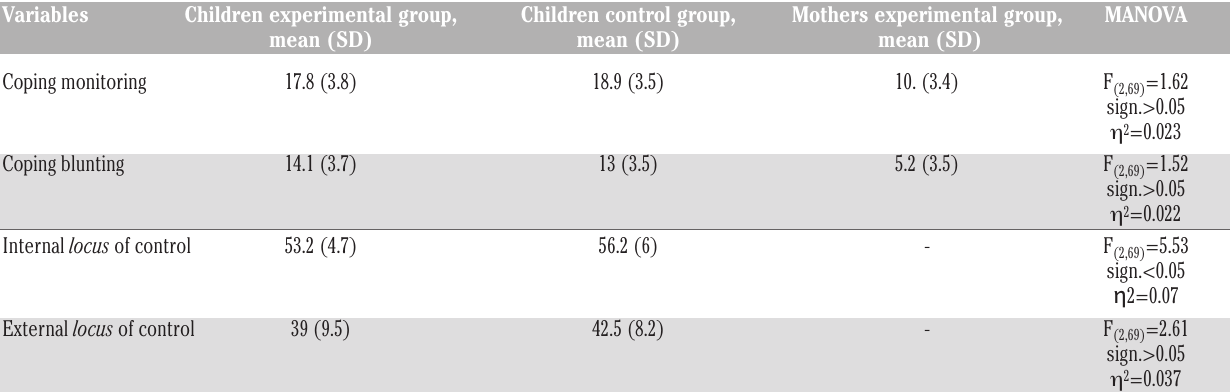
Table 2. Descriptive statistics and multivariate analysis of variance (MANOVA): experimental group (40 children and their mothers) and control group (30 children). Variables Children experimental group, Children control